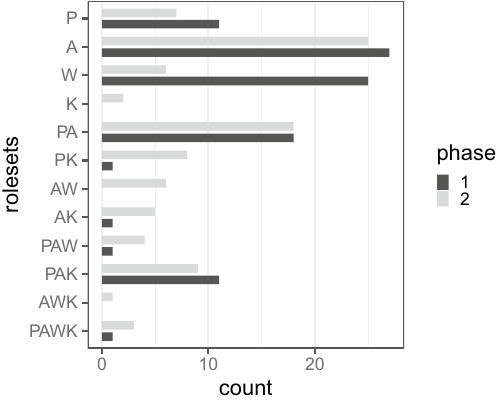
Fig. 2 Graphical representation of distribution of role structures in Phase 1 and Phase